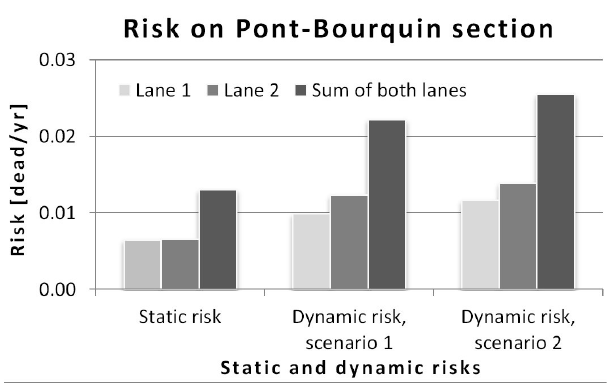
Fig. B2. Risk results on Pont-Bourquin section.